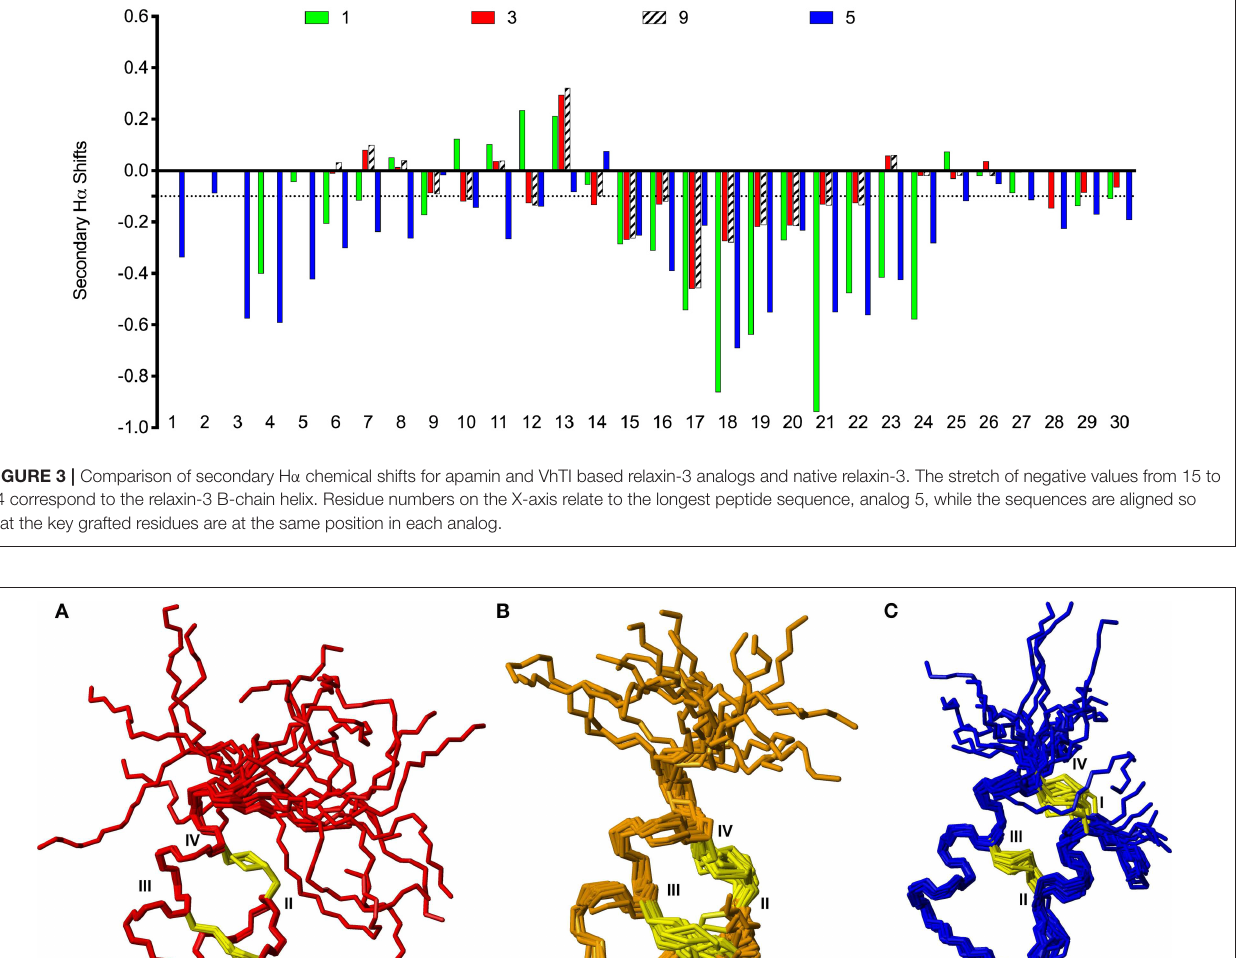
Frontiers in Chemistry |